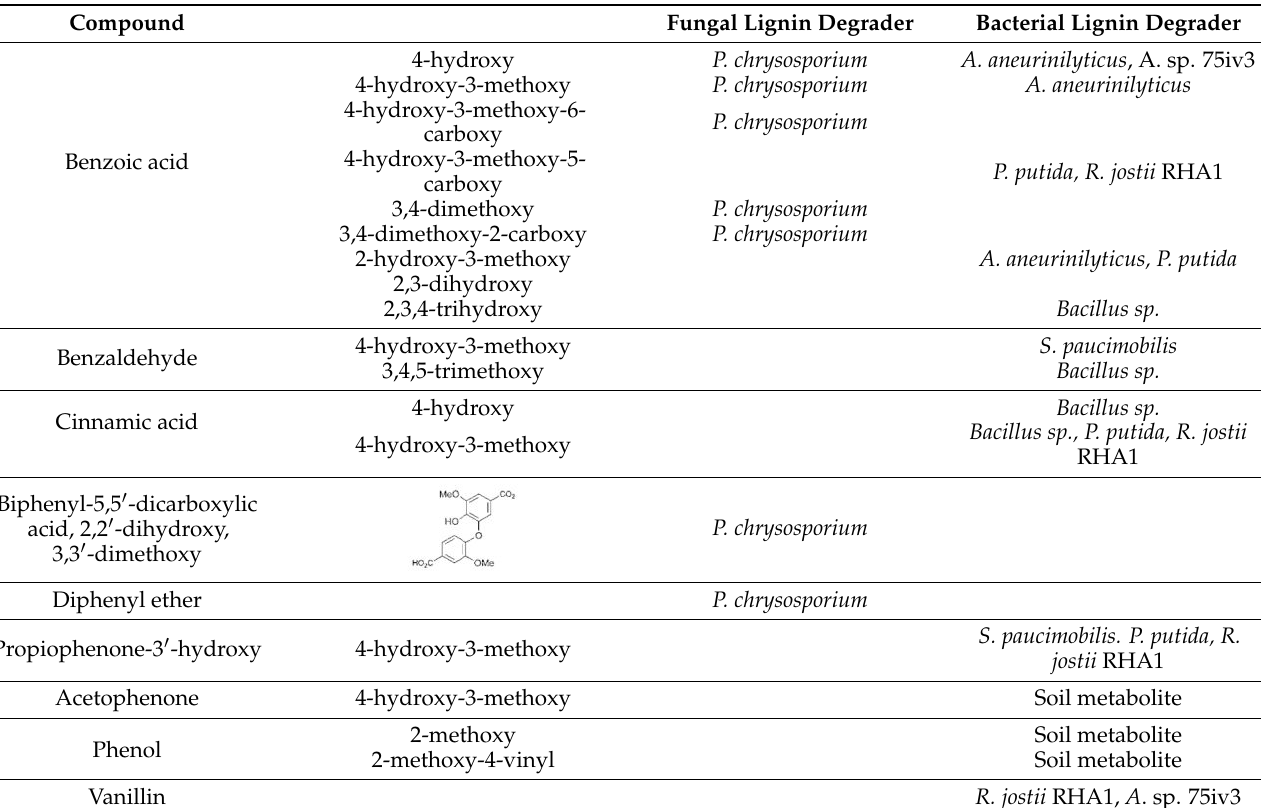
Table 4. Aromatic products detected from lignin breakdown